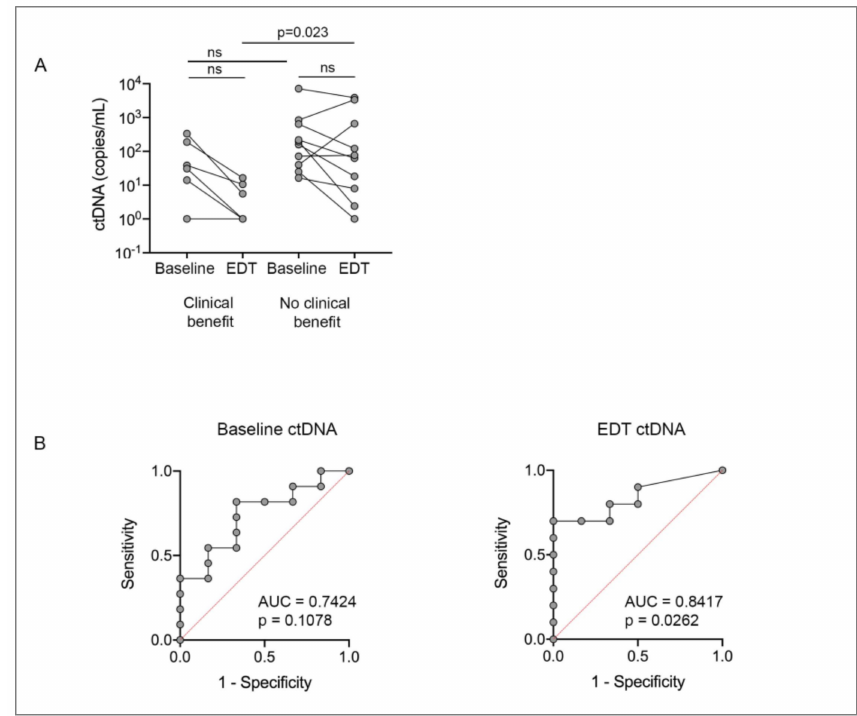
Figure 2. Predictive performance of ctDNA. ( A ) ctDNA changes from baseline to EDT in clinical benefit group ( n = 6) and no clinical benefit group ( n = 10) patients. Patient matched PRE-EDT ctDNA levels were compared using Wilcoxon matched-pairs signed rank test, and unpaired PRE or EDT ctDNA levels between clinical benefit and no clinical benefit patients were compared using the Mann–Whitney test. ( B ) ROC curve analysis determined a negative predictive cut-off value (i.e., value providing maximum sensitivity and specificity) for ctDNA > 16.35 copies/mL at EDT for no clinical benefit. ns, not significant; AUC, area under the